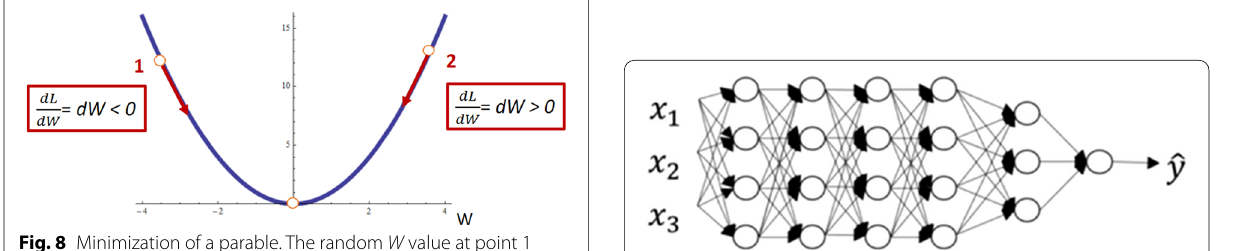
Fig. 10 Neural network with 5 hidden